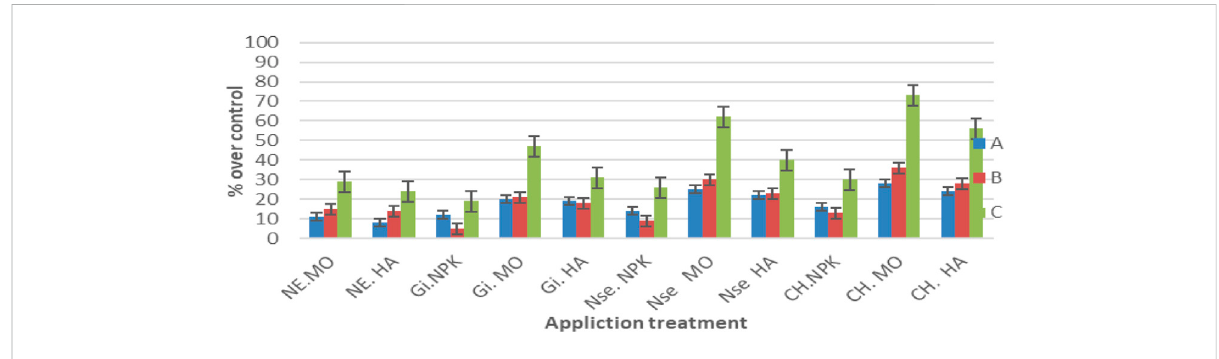
FIGURE 1 A: FLY and DLY as % over control. B: NE as % over control. C: NE yield.